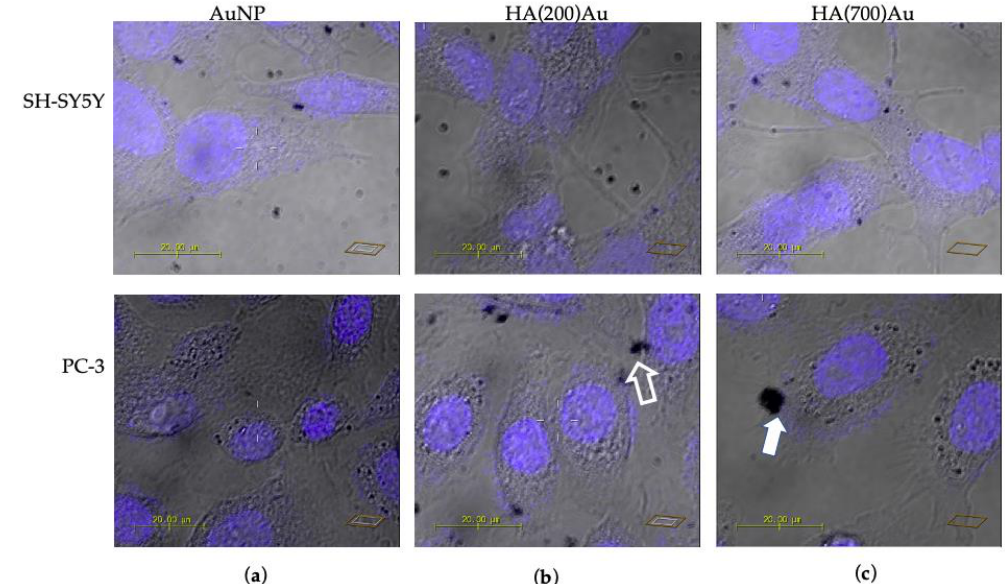
Figure 9. Merged confocal images of Hoechst staining (λ ex/em = 405/425–450 nm) + optical bright field micrographs of neuroblastoma (SH-SY5Y, upper panels) and prostate cancer (PC-3, lower panels) cells dye-labelled and fixed after 90 min of incubation with: ( a ) AuNP (0.005 nM = 5.5 × 10 2 NP / mL); ( b ) HA(200)Au (0.0010 nM = 7.2 NP / mL, 0.1% w / v HA); ( c ) HA(700)Au (0.0011 nM = 2.5 × 10 1 NP / mL, 0.1% w / v HA). Scale bar = 20 µ m. The arrows point to gold nanoparticle aggregates (dark features in the optical micrographs). Int. J. Mol. Sci. 2020 , 21 , x FOR PEER REVIEW